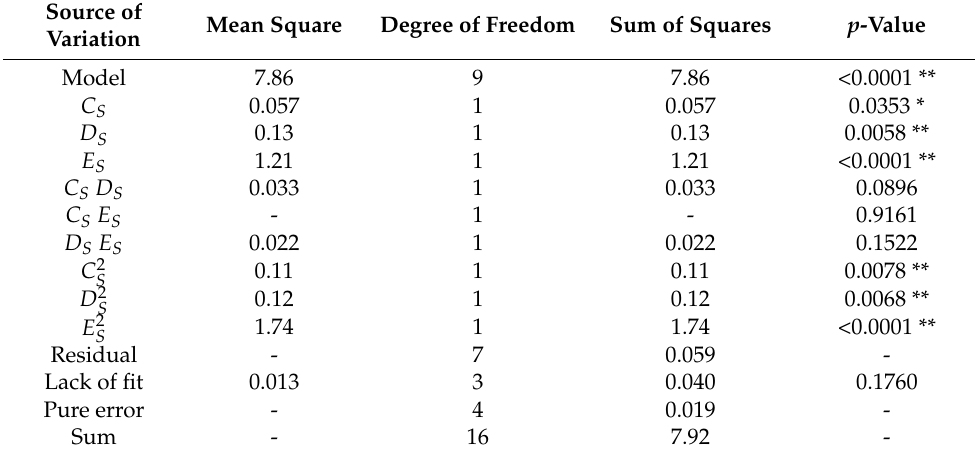
Pure error - Sum - 7.92